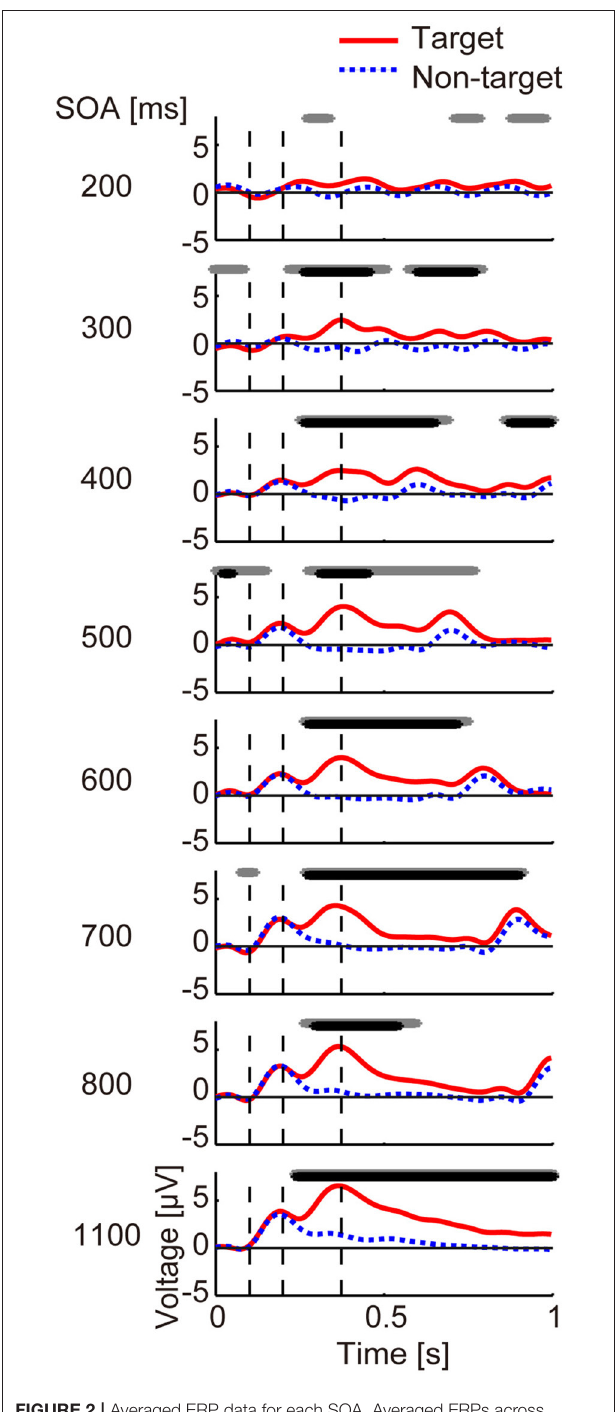
FIGURE 2 | Averaged ERP data for each SOA. Averaged ERPs across participants at channel Pz from 0 to 1s. The red line shows target data and the blue dashed line shows non-target data. The black and gray lines at the top of each panel represent duration, showing a significant difference between target and non-target data using paired t -tests ( p < 0.05) with and without FDR correction, respectively. Vertical dashed lines show the averaged latencies (98, 203, and 375ms; average across SOA conditions) at which positive or negative peaks occurred, each of which probably represents N100, P200, and P300,